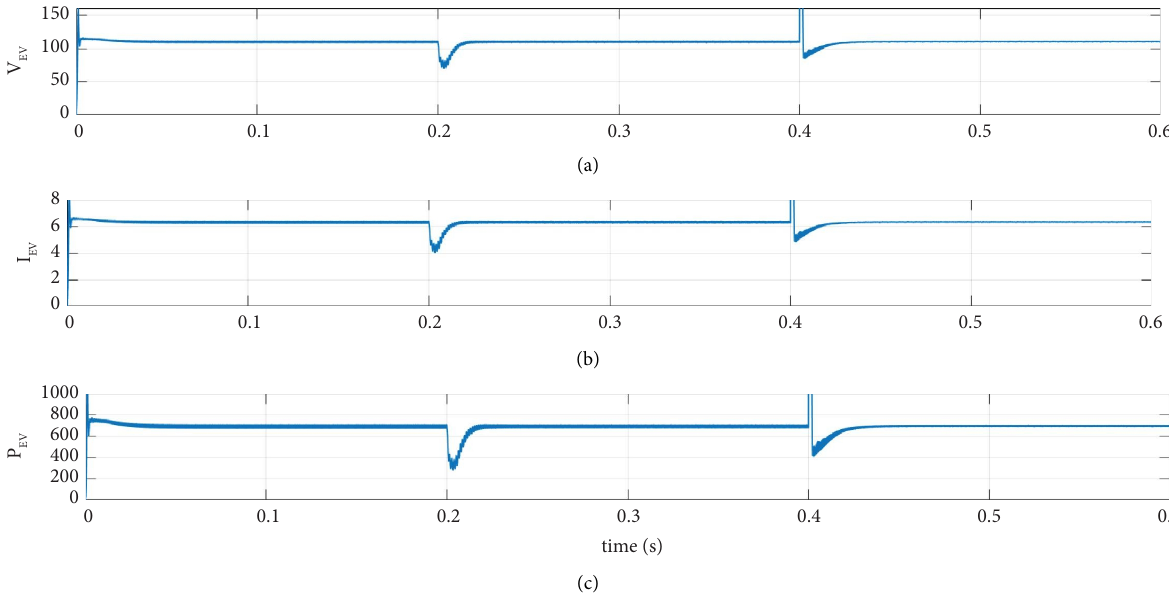
Figure 11: Simulation results (a) EVs voltage (b) EVs current (c) EVs power.